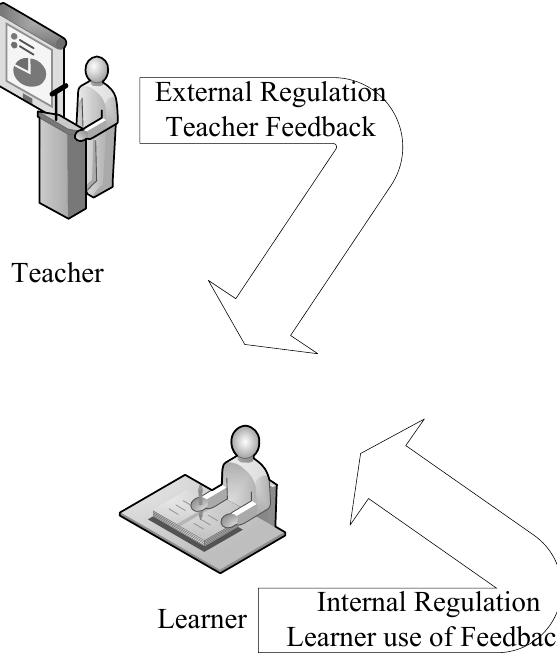
Fig. 4. A heuristic for understanding the role of teacher feedback in formative assessment and student learning [adapted from